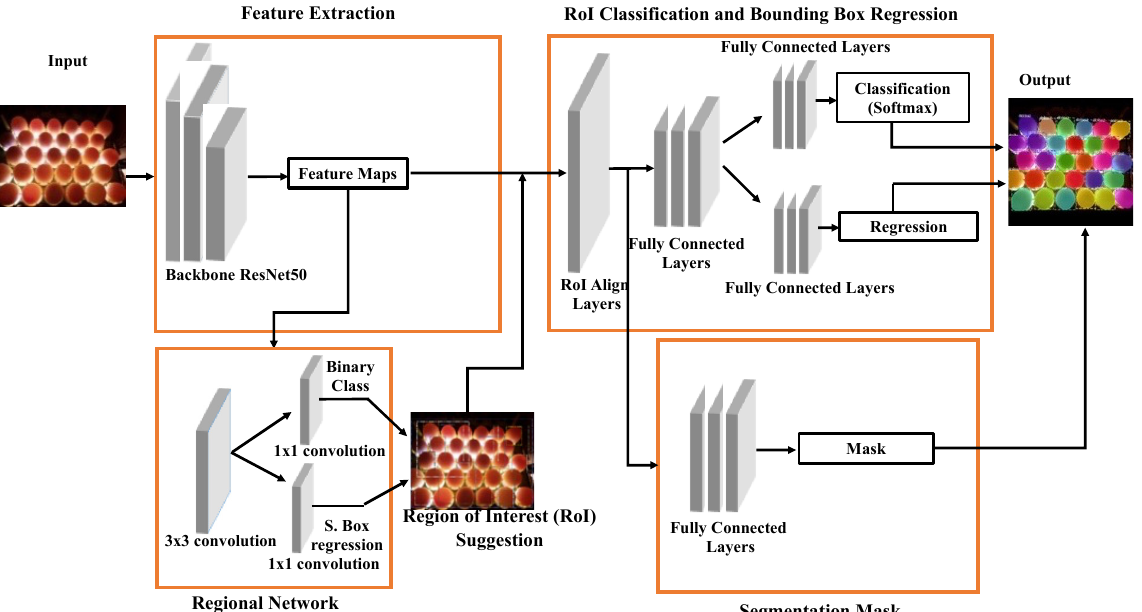
Figure 3. Overview of the Mask R-CNN architecture.